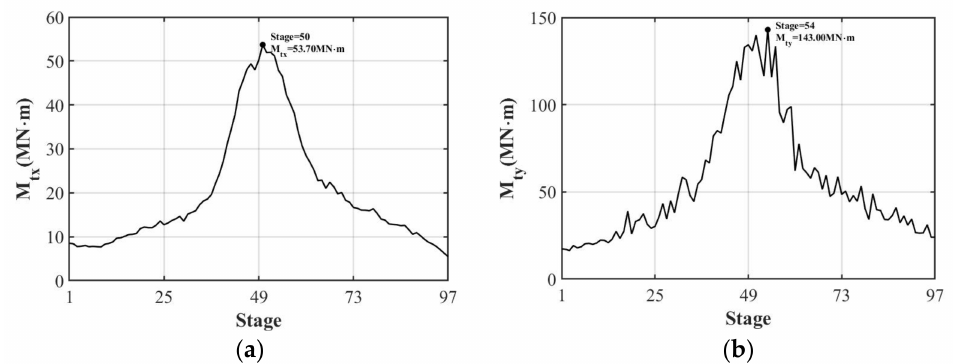
Figure 18. Maximum loads of the tower base at different stages: ( a ) Tower-base side-to-side bending moment and ( b ) Tower-base fore-aft bending